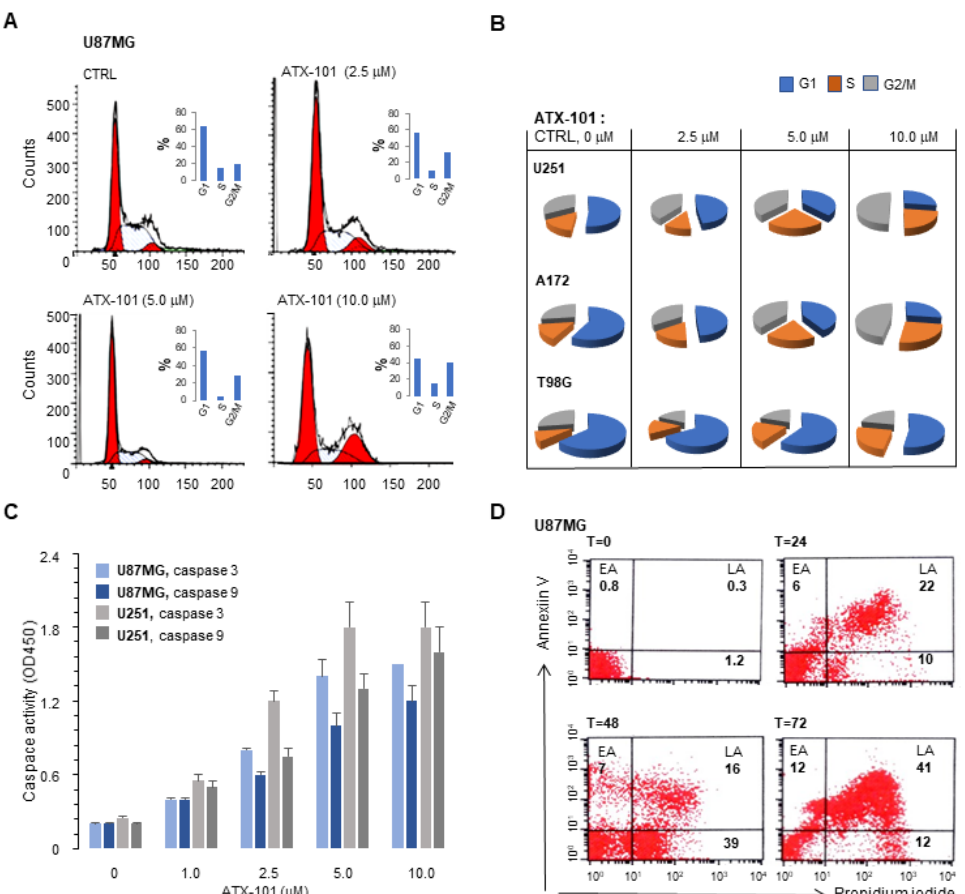
Figure 3. ATX-101 induces G2/M cell arrest and mediates apoptosis. ( A ) Cell cycle analysis of U87MG cells after treatment with ATX-101 (2.5–10 μ M) for 24 h. Diploid G1 and diploid G2 cells are marked in red. ( B ) Graphic presentations of cell cycle analysis as in A for U251, A172, and T98G cells. ( C ) Enzymatic caspase 9 and 3 activity in U87MG and U251 cells treated with ATX-101 (2.5–10 μ M) for 24 h. Means ± SD of three independent experiments analyzed in triplicates. ( D ) Annexin V and necrosis (by propidium iodide) FACS analyses of U87MG at different time points (T = hours) after addition of 2.5 μ M ATX-101. EA = early apoptosis. LA = late apoptosis.